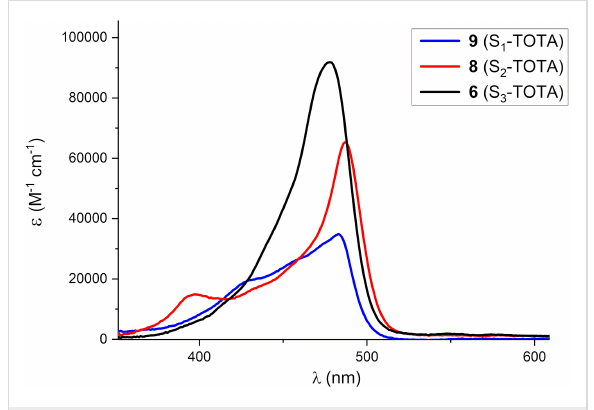
Figure 5: UV–vis spectra in CH 2 Cl 2 : S 1 -TOTA + ( 9 , blue line), S 2 -TOTA + ( 8 , red line), and S 3 -TOTA + ( 6 , black line).